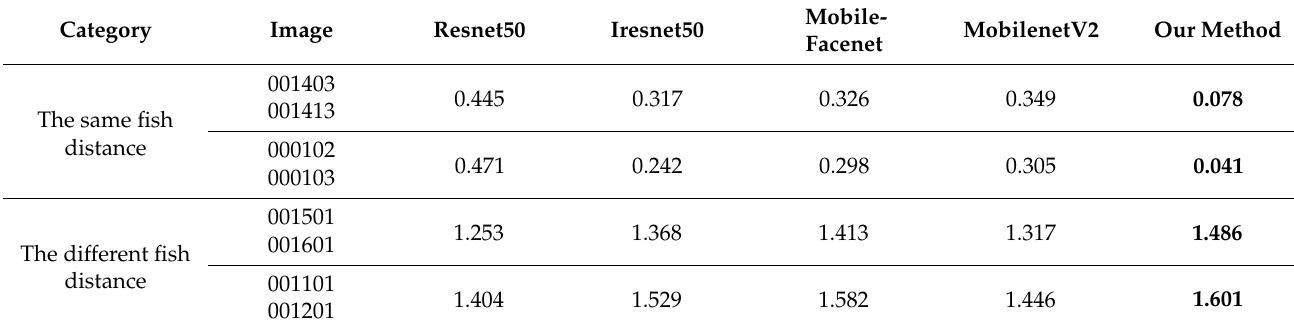
Table 4. Comparison of fish distance performance in different networks.